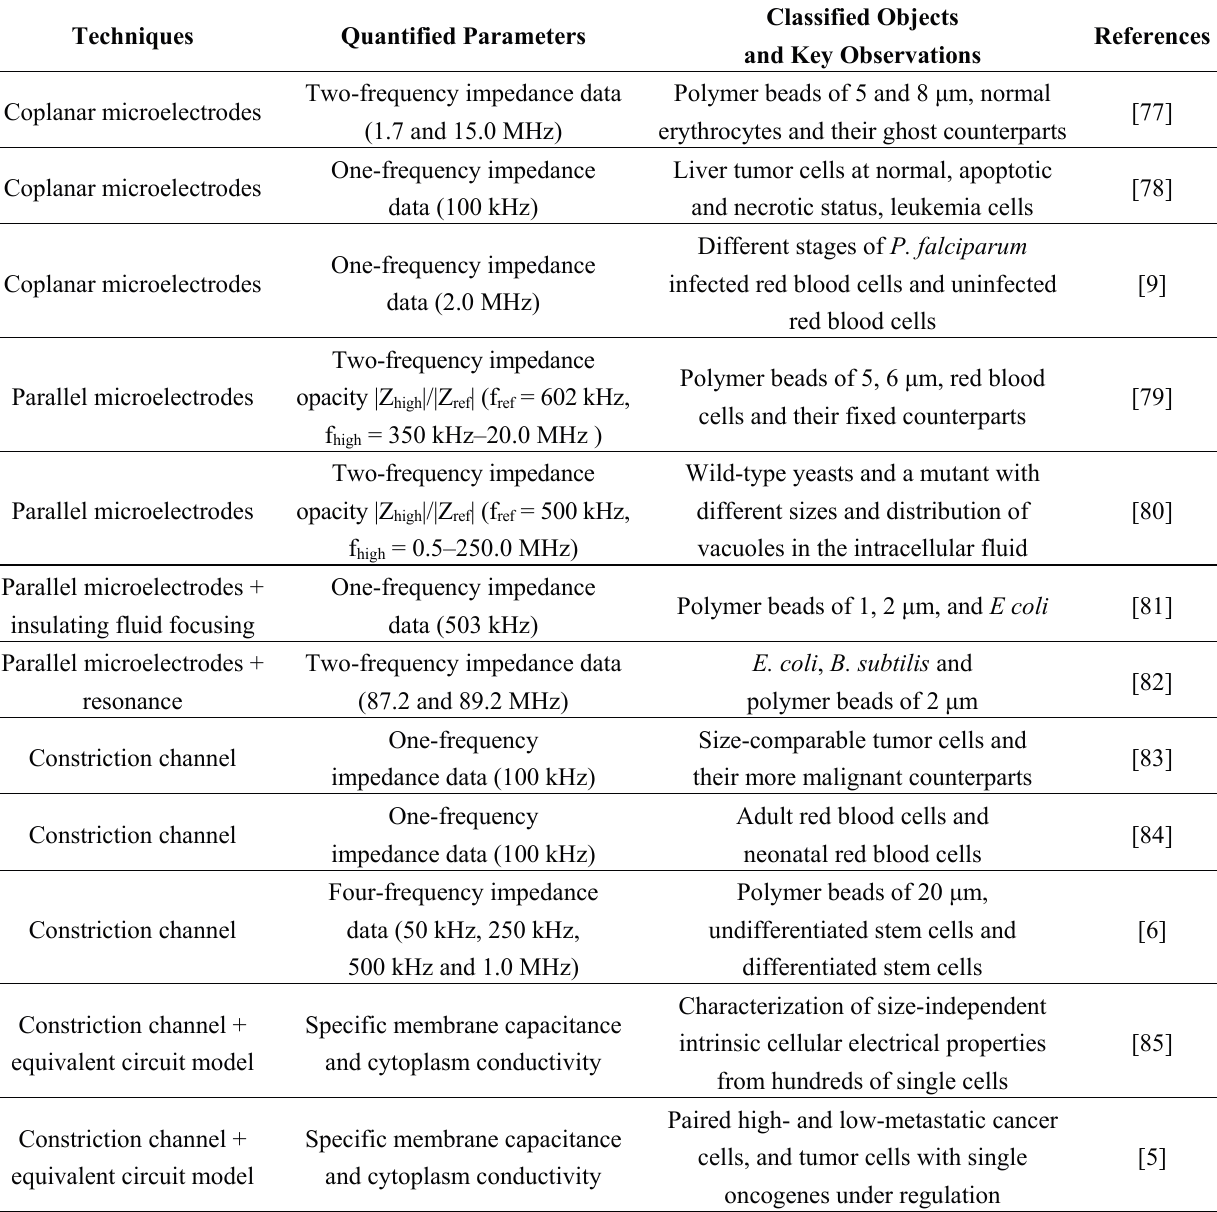
Table 1. Key developments in the field of microfluidic impedance flow cytometry enabling high-throughput cellular electrical property